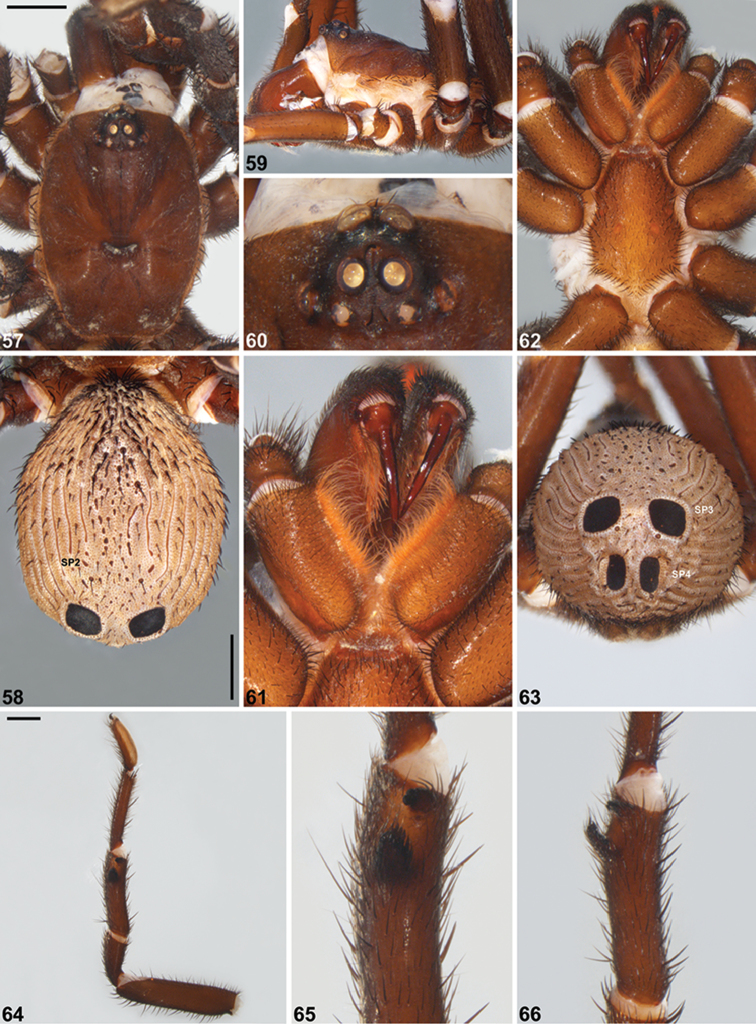

Idiosoma
arenaceum sp. n., male holotype (WAM T139527) from Zuytdorp (Western Australia; GES), somatic morphology. 57–58 Carapace and abdomen, dorsal view 59 Carapace, lateral view 60 Eyes, dorsal view 61 Mouthparts, ventral view 62 Sternum, ventral view 63 Abdomen, posterior view 64 Leg I, prolateral view 65 Leg I tibia, clasping spurs, prolateral view 66 Leg I tibia, proventral view. Scale bars 2.0. SP2–4 = sigilla pairs 2–4.